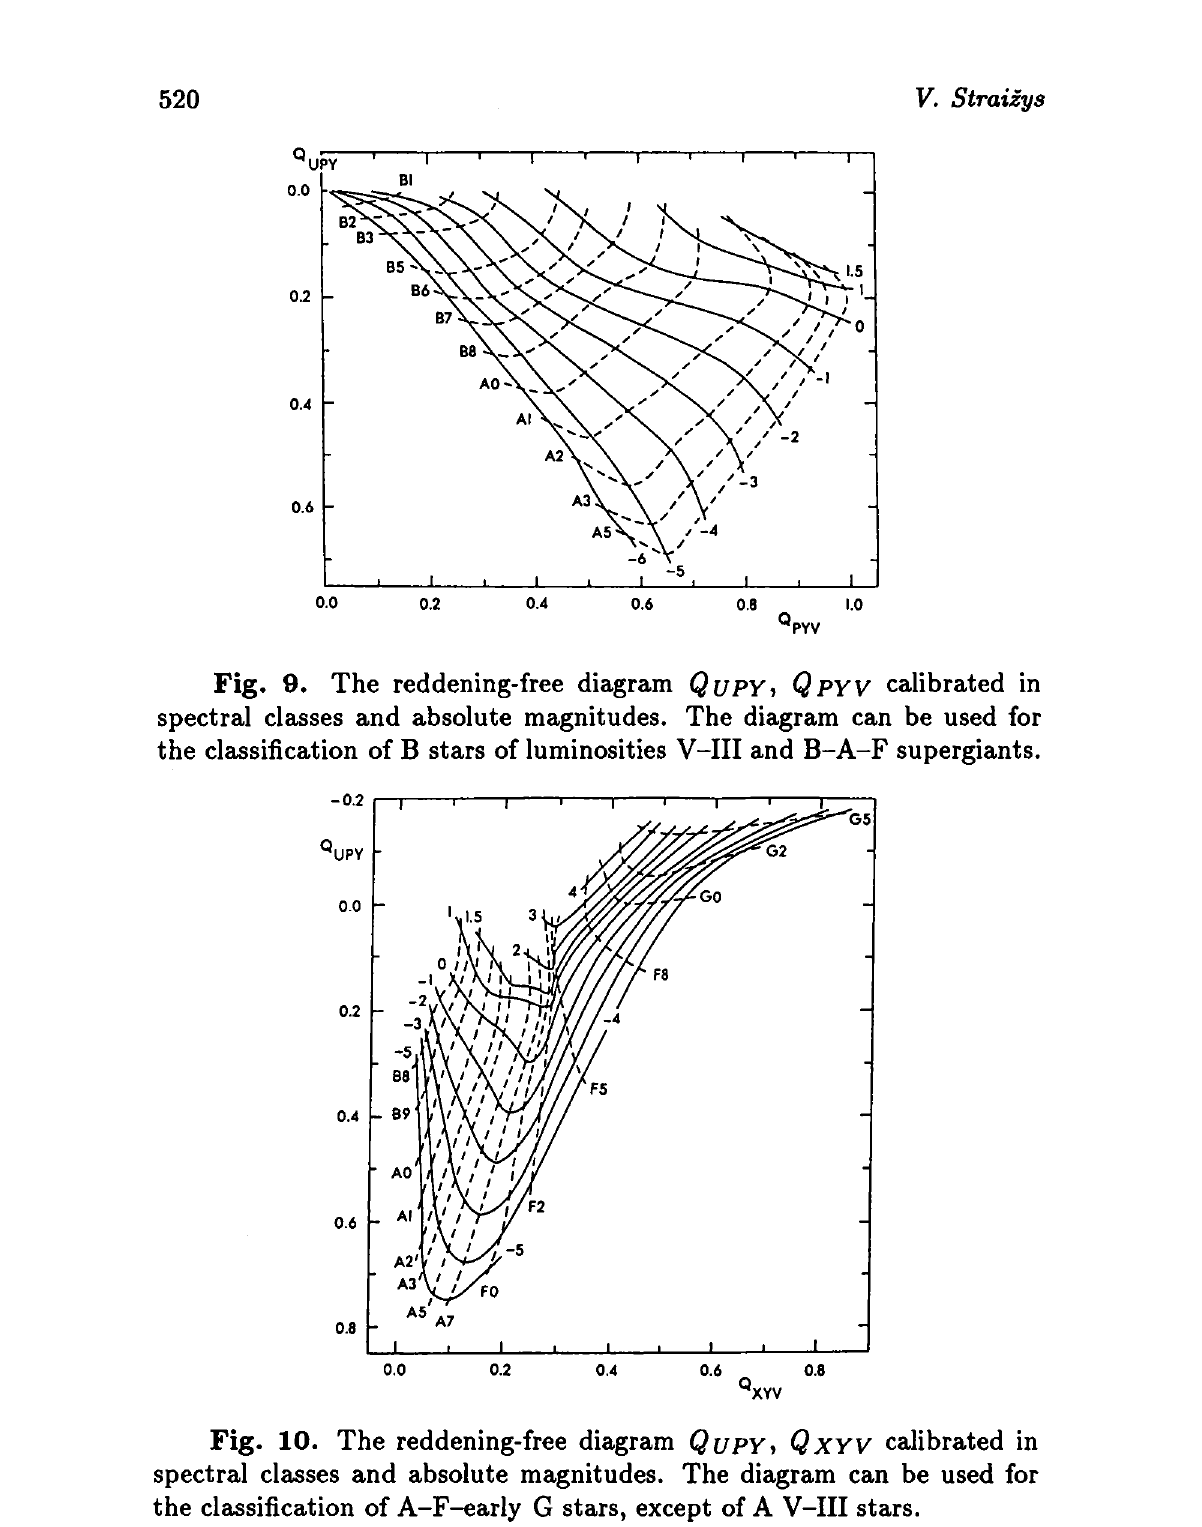
Fig. 10. The reddening-free diagram QuPY» QxYV calibrated in spectral classes and absolute magnitudes. The diagram can be used for the classification of A-F-early G stars, except of A V-III